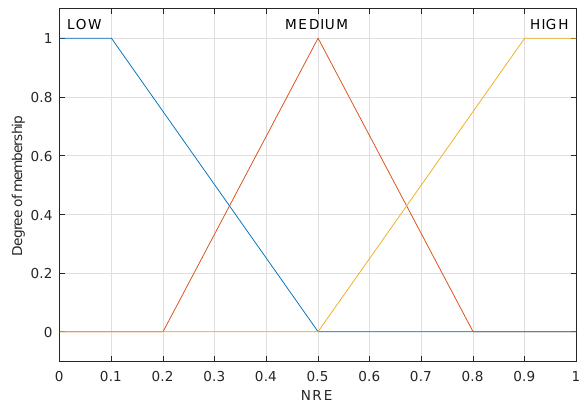
Figure 4. Membership function of NRE.